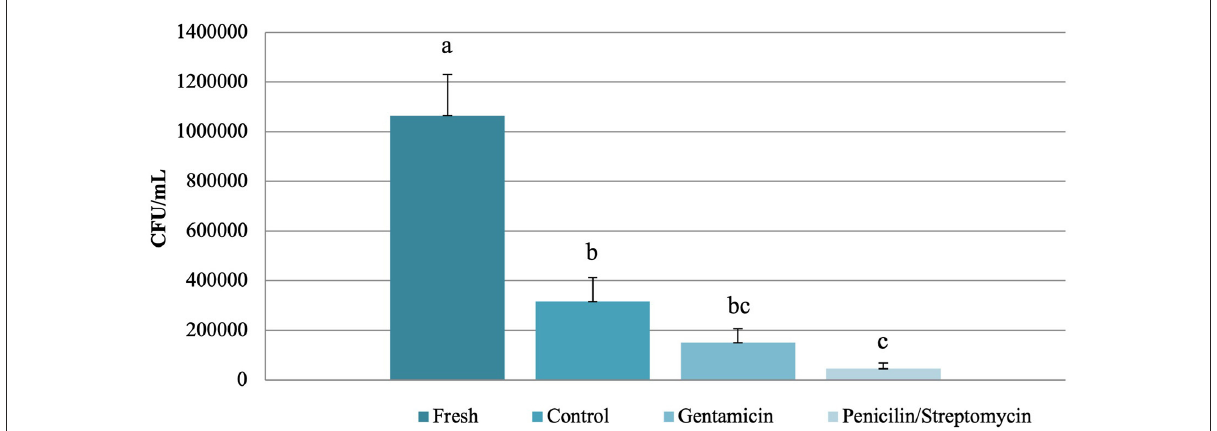
FIGURE1 Mean ( ± SEM) values for bacterial load (CFU/mL) in fresh and frozen-thawed semen from collared peccaries ( n = 10) supplemented of not with different antibiotics (gentamicin and streptomycin-penicillin combination). a–c Lowercase letters indicate significant differences for fresh and treatment groups (Dunnett’s test; P < 0.05).